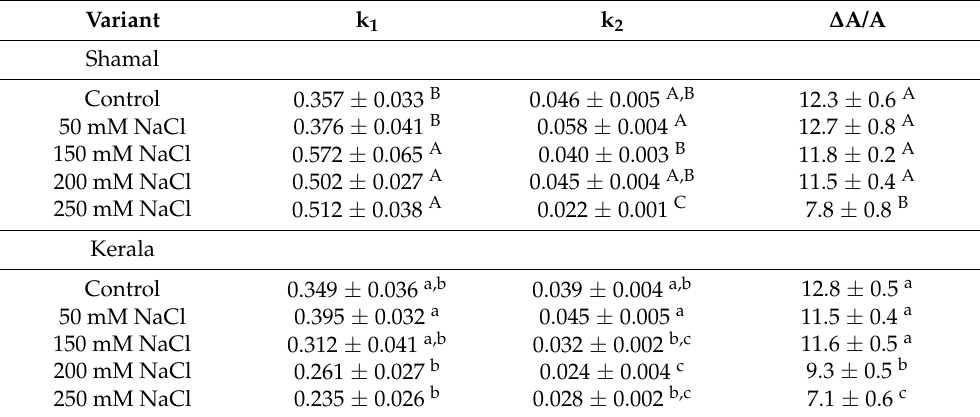
Table 3. Effects of different NaCl concentrations on the photooxidation of P 700 in leaves of sorghum ( Sorghum bicolor L. Shamal) and maize ( Zea mays L. Kerala). The far-red-light-induced